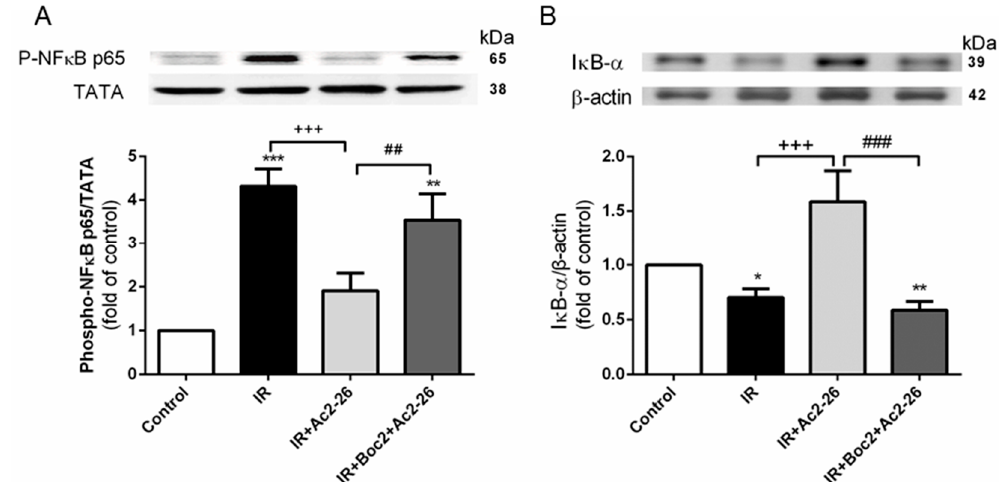
Figure 9. Effect of Ac2-26 and Boc2 on the NF- κ B signaling pathway in lung tissues. Ac2-26 reduced nuclear phosphorylated NF- κ B p65 levels ( A ) and increased the inhibitor of NF- κ B (I κ B)- α levels ( B ) in IR-induced lung injury. The addition of Boc2 attenuated the protective effect of Ac2-26. TATA and β -actin served as loading controls for nuclear and cytoplasmic proteins, respectively. Representative blots are shown. Data are expressed as means ± SD ( n = 6 per group). * p < 0.05, ** p < 0.01, *** p < 0.001, compared with the control group; +++ p < 0.001, compared with the IR-vehicle group; and ## p < 0.01, ### p < 0.001, compared with the IR+Ac2-26 group.